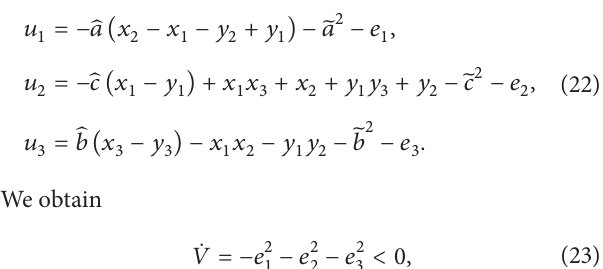
which is negative semidefinite function of 𝑒 1 , 𝑒 2 , 𝑒 3 , ̂𝑎 , The Lyapunov asymptotical stability theorem is not